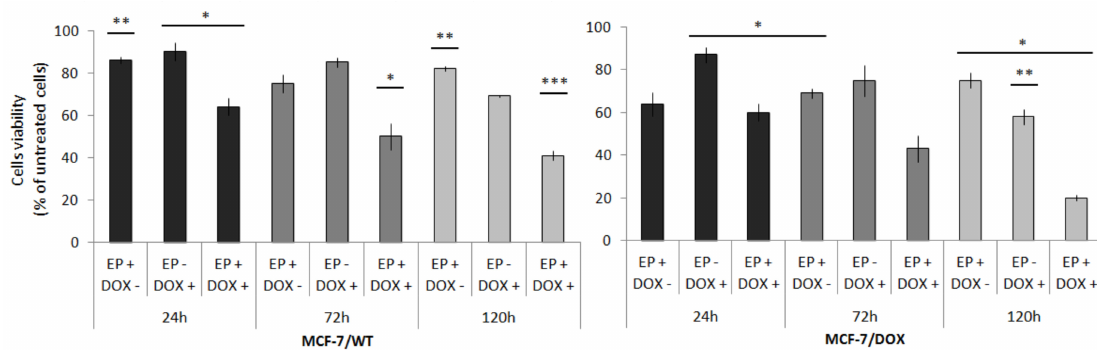
Figure2. TheresultsofMTTassayfollowingtheapplicationofelectricpulses((EP + )8pulses, durationof